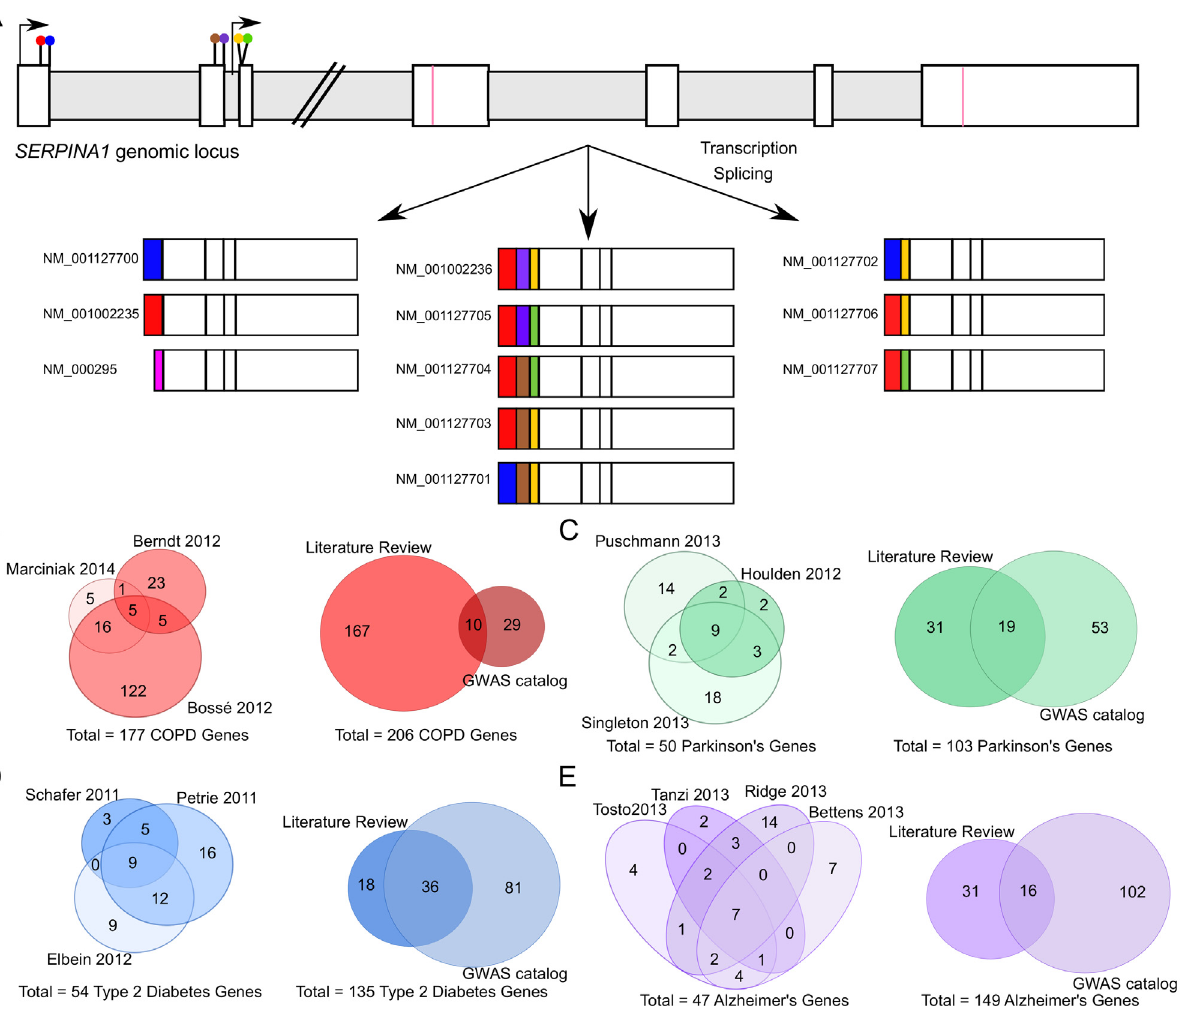
Fig 1. Combining sources to identify genes associated with COPD. (A) The COPD-associated gene, SERPINA1 , is alternatively spliced to produce 11 different transcripts. Two transcription start sites are indicated by arrows; splice sites are shown as colored lollipops. Exons are indicated by white bars and introns by horizontal gray bars. The coding sequence start and stop codons are indicated with pink lines. 11 transcripts are depicted and colored by splice site selection. The 11 transcripts make SERPINA1 a particularly complex gene in terms of alternative splicing, 99.5% of human genes have fewer transcripts. (B) COPD-associated genes were identified by merging disease-associated genes from different literature reviews (left) and combining them with genes from the NHGRI GWAS catalog (right). Other comparative disease lists were compiled in the same manner, including (C) Parkinson ’ s disease-associated genes, (D) Type 2 diabetes-associated genes and (E) Alzheimer ’ s disease-associated genes. The number of genes from each source is indicated in the Venn